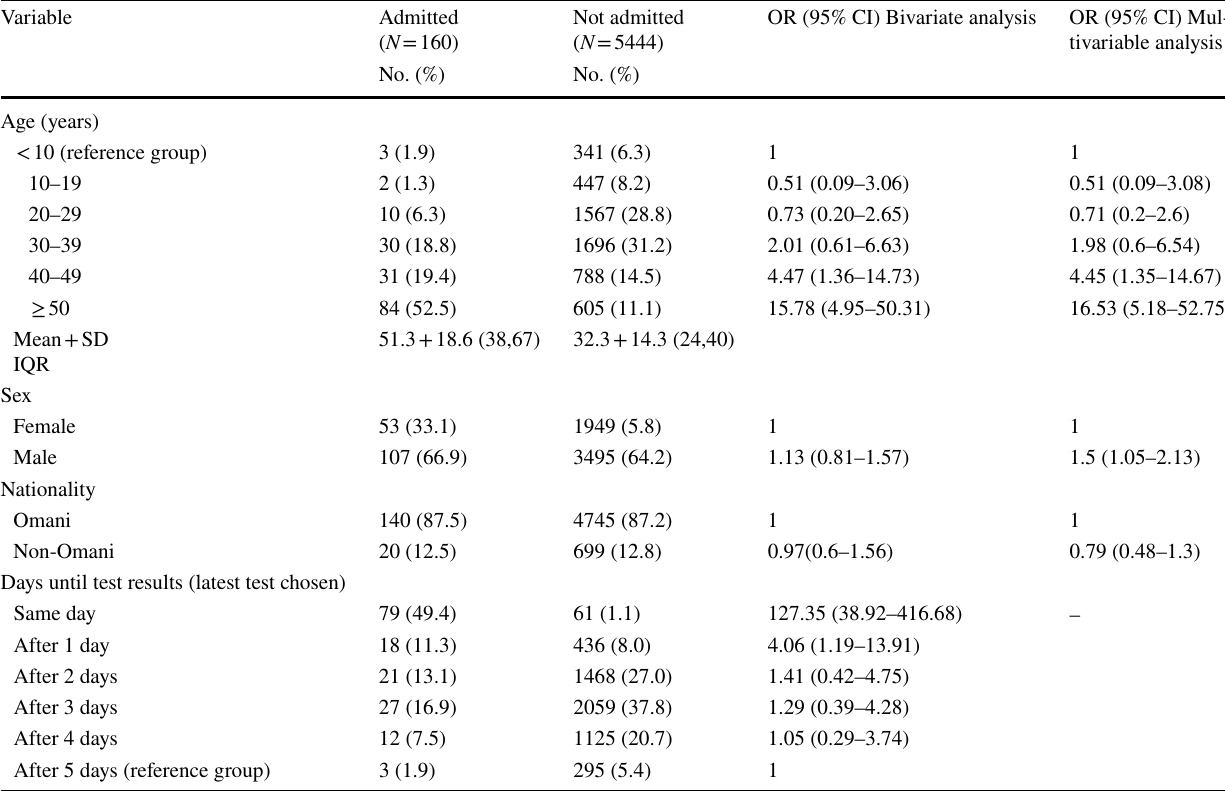
Table 3 Age, sex, nationality, and time for release of results for admitted vs. non-admitted patients in South Batinah until 13 July 2020